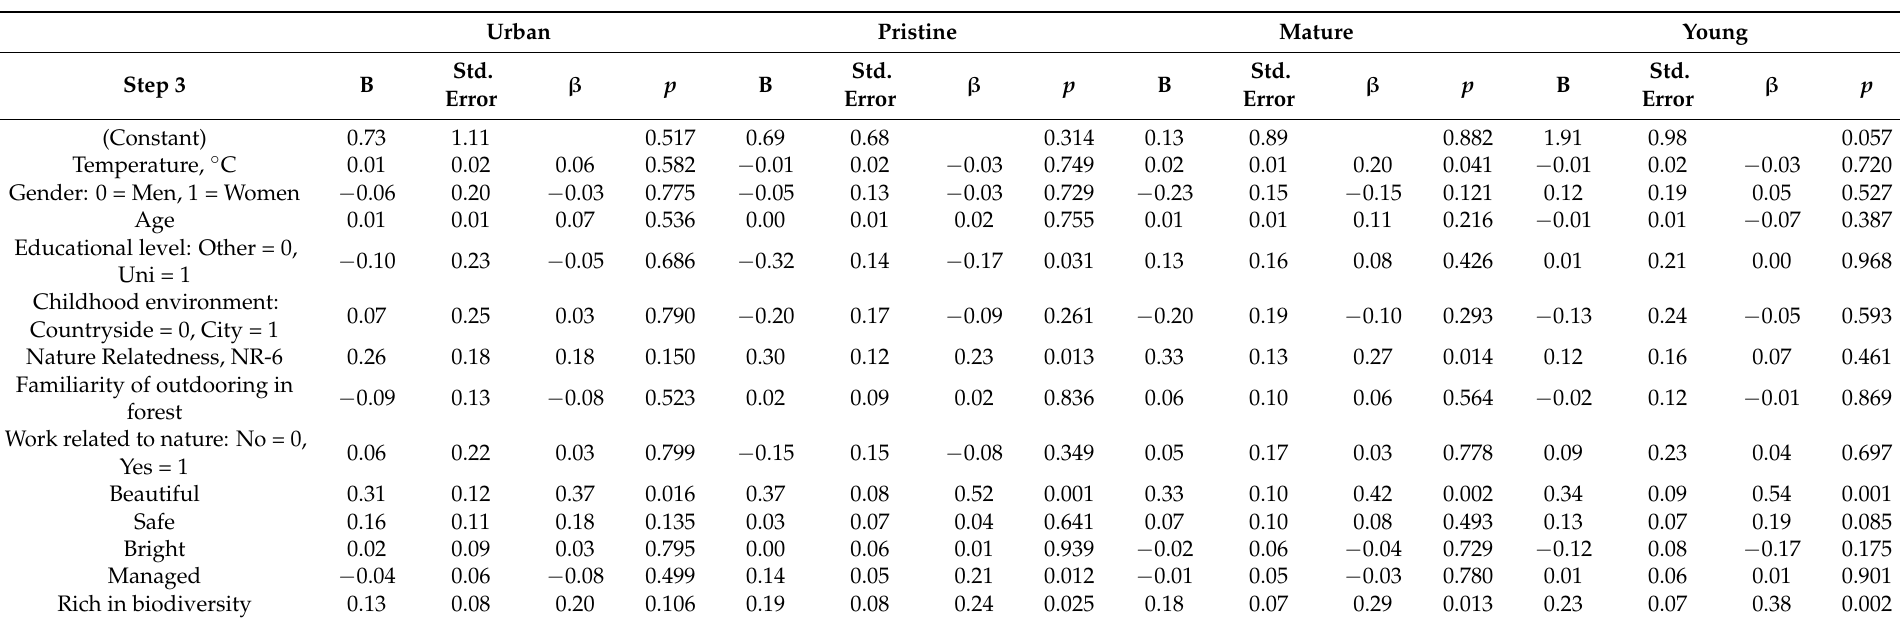
Table 6. Final model (step three) for the multiple regression analyses for variables predicting overall perceived restorativeness (PRS-score) in four different forests. Urban Pristine Mature